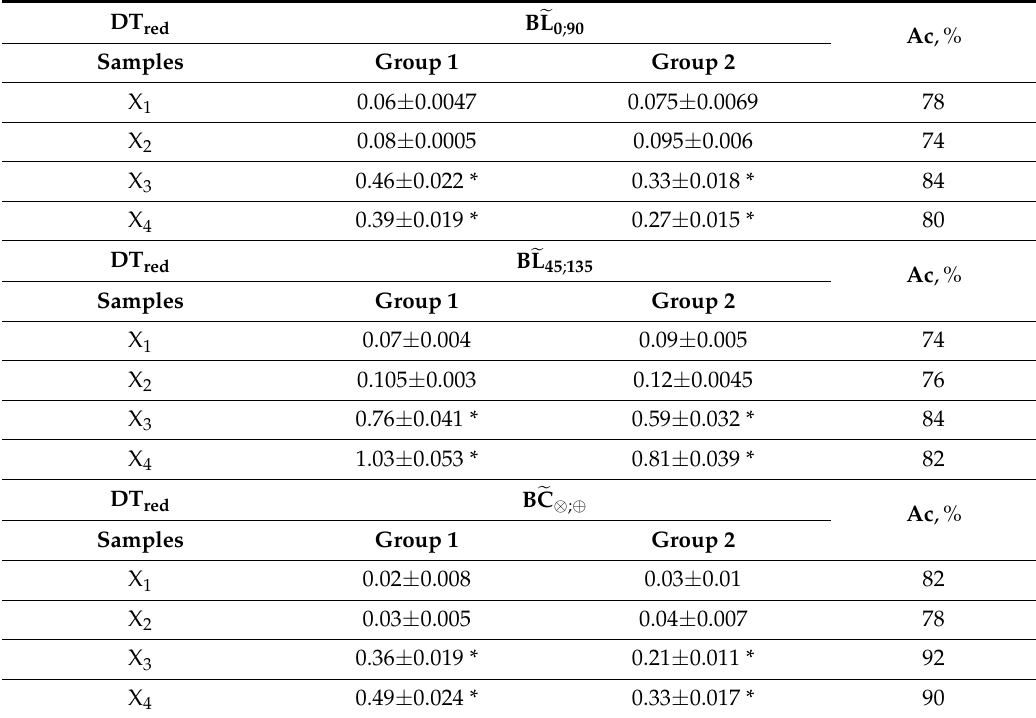
Table 2. Efficiency of statistical analysis of diffuse tomograms of polycrystalline blood films for the differentiation between healthy donors and patients with prostate cancer